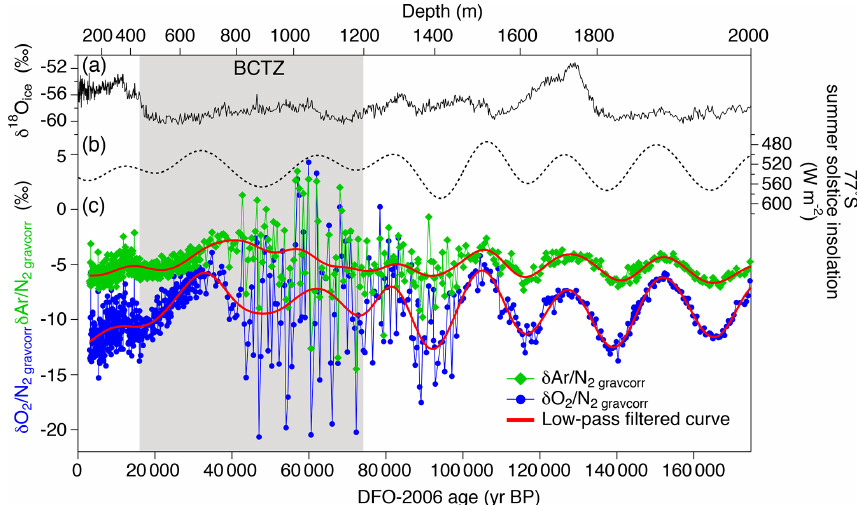
Figure 4. δ O 2 / N 2gravcorr and δ Ar / N 2gravcorr with published records plotted against the age of ice. (a) Stable water isotope record (Uemura et al., 2018), (b) summer solstice insolation at Dome Fuji (Laskar et al., 2004), and (c) δ O 2 / N 2gravcorr and δ Ar / N 2gravcorr with low-pass- filtered curves (cut-off at 16.7kyr; the filter was designed by Kawamura et al., 2007) (red lines).